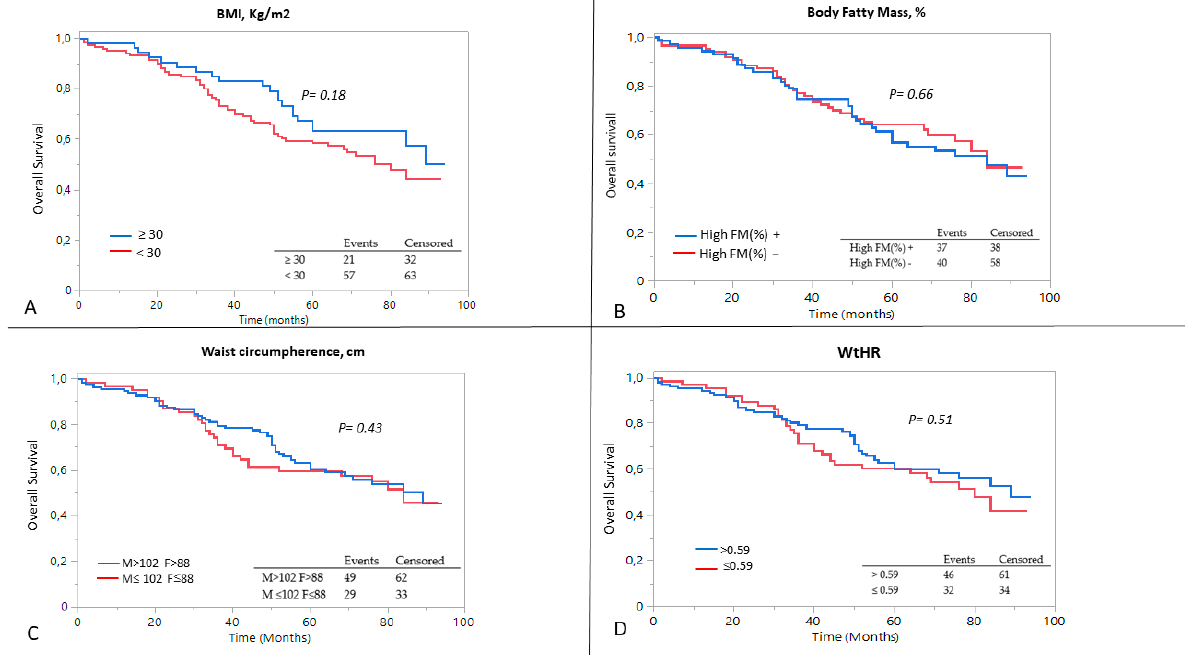
Figure 1. Kaplan–Meier curves for the composite outcome of ESKD and mortality, after dividing the patients on the basis of ( A ) BMI, ( B ) percentage of body fat mass, ( C ) waist circumference and ( D ) waist-to-height ratio. A log-rank analysis was conducted.